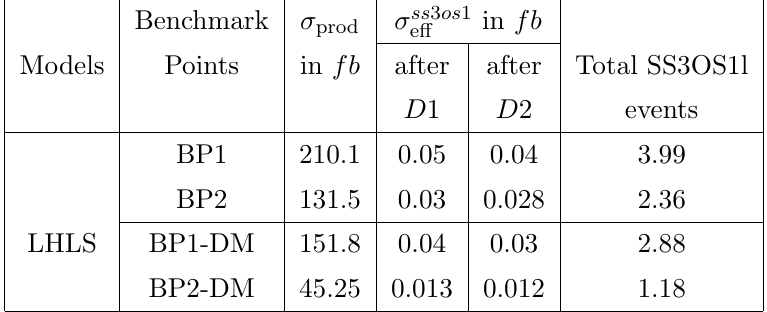
after successive cuts e(cid:11)